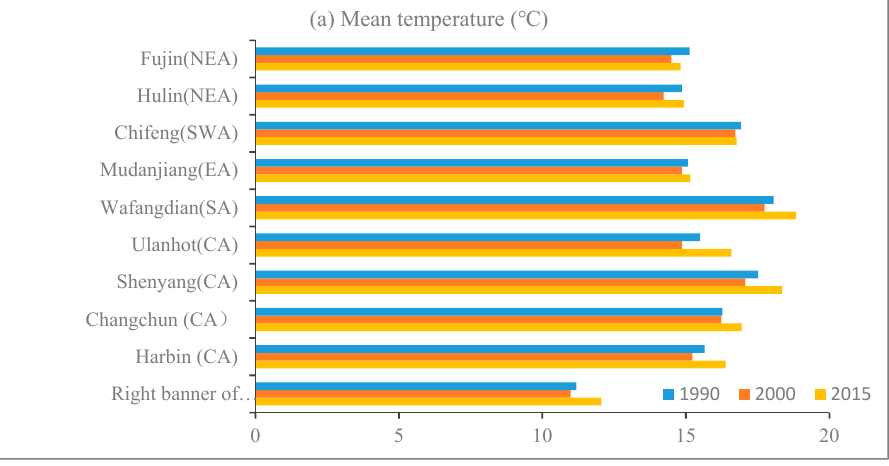
Figure 9. The variation of three meteorological factors for the 10 stations during the maize growth period from 1990 to 2015 in Northeast China. (a) Mean temperature; (b) Total precipitation; (c) Total sunshine duration.